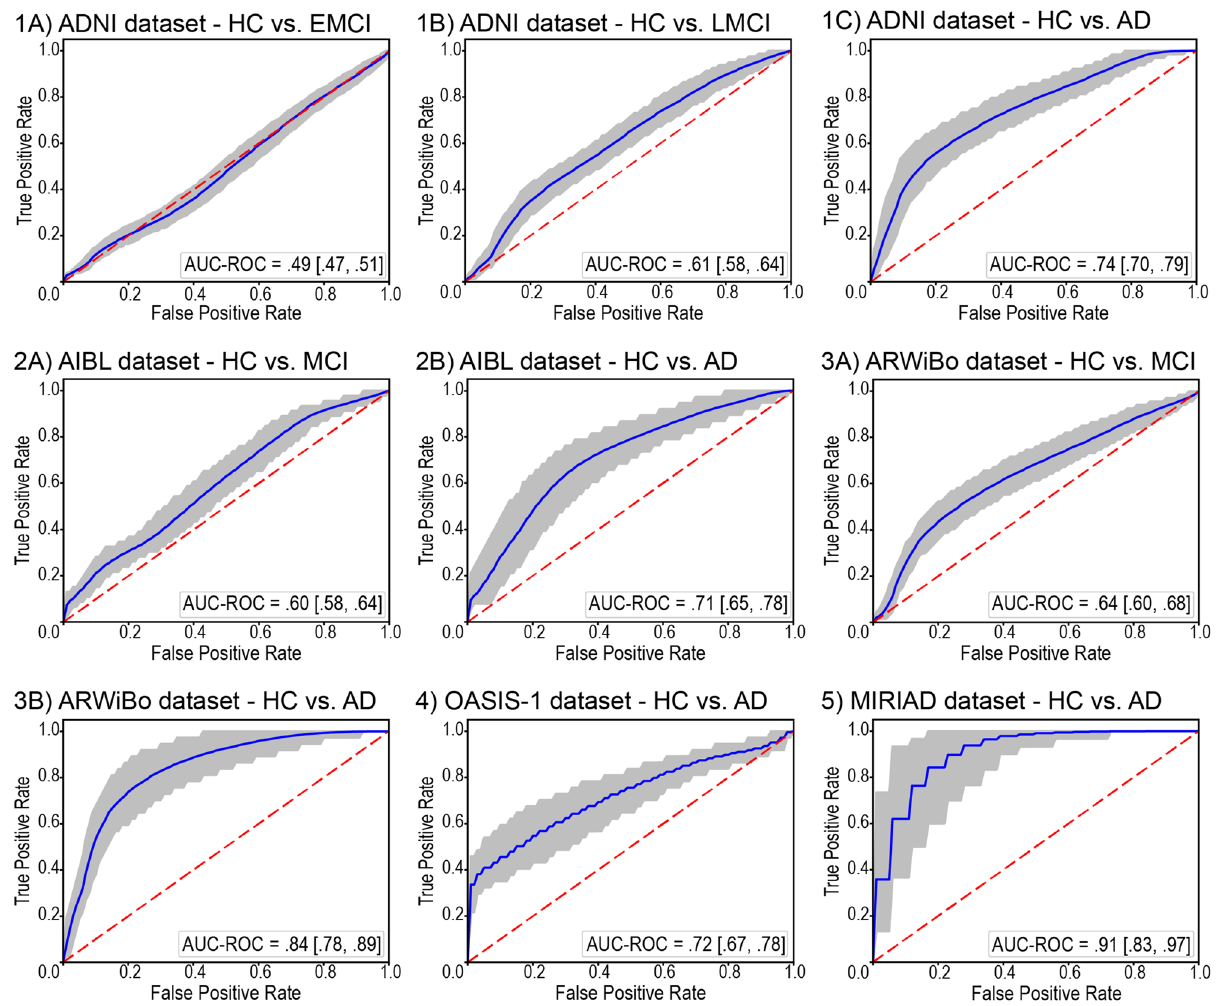
Figure 3. Discriminative performance of the normative approach. The solid line indicates the mean receiver operating characteristic curve across the bootstrap iterations with the shaded area indicating the 95% confidence interval calculated using the percentile method on the bootstrap analysis. The dashed line indicates the chance level. Abbreviations: AD = Alzheimer’s disease; AUC-ROC = area under the receiver operating characteristic curve; EMCI = early mild cognitive impairment; LMCI = late mild cognitive impairment; MCI = mild cognitive impairment; HC = healthy controls; ADNI = Alzheimer’s Disease Neuroimaging Initiative; AIBL = Australian Imaging Biomarkers and Lifestyle Study of Ageing; ARWiBo = Alzheimer’s Disease Repository Without Borders; OASIS-1 = Open Access Series of Imaging Studies: Cross-Sectional; MIRIAD = Minimal Interval Resonance Imaging in Alzheimer’s